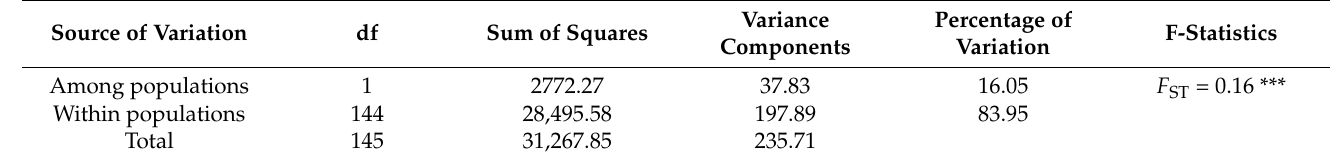
Table 2. Analysis of molecular variance (AMOVA) using 1519 SNPs of the genetic variation among and within two subpopulations of 73 B. gymnorhiza accessions. Variance Percentage of F-Statistics Source of Variation df Sum of Squares Components Variation Among populations 1 2772.27 37.83 Within populations 144 28,495.58 197.89